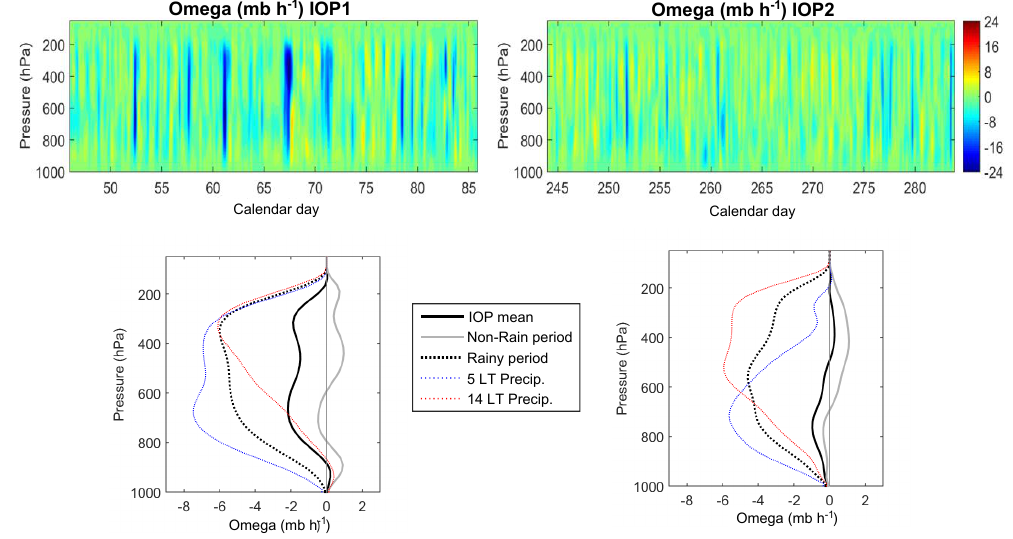
Figure 4. The time series (top) and temporal mean profiles (bottom) of large-scale vertical velocity for IOP1 (left) and IOP2